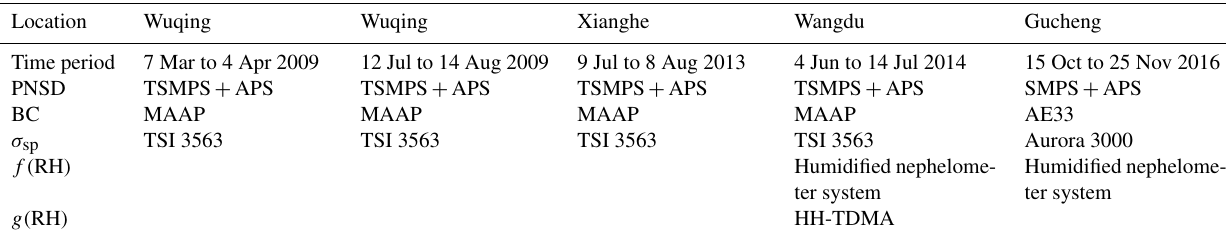
Table 1. Locations, time periods, and datasets of five field campaigns that were used.